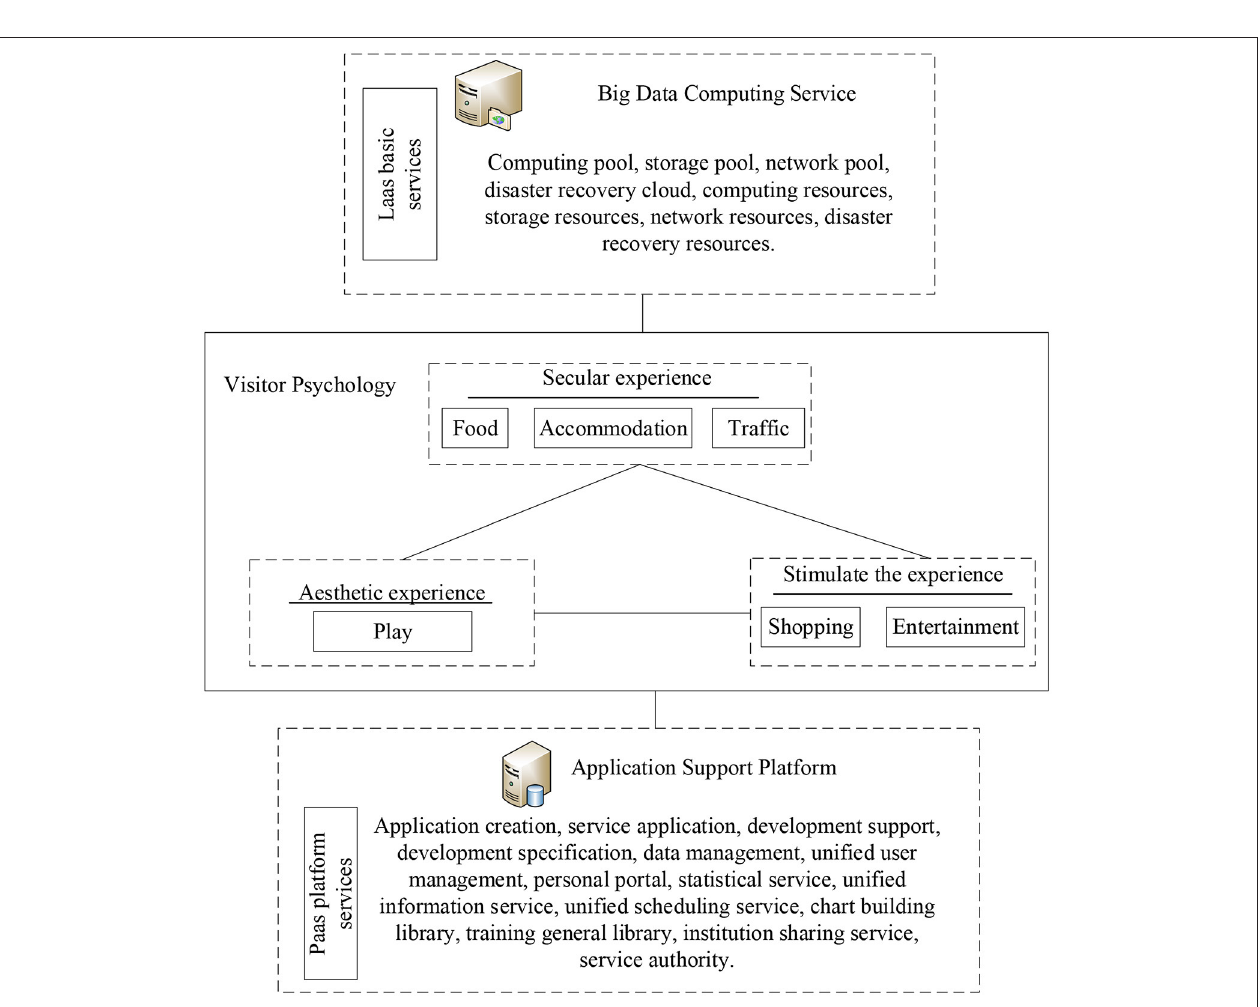
FIGURE 4 | The smart tourism platform based on tourist